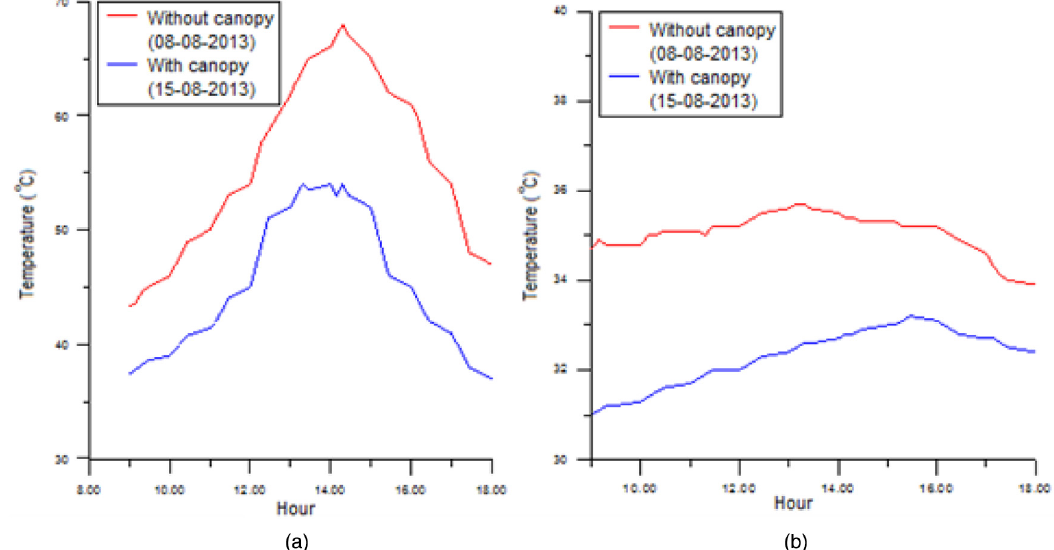
Fig. 6. Surface temperatures of the roof in the ef fi cient model. (a) external surface temperature; (b) internal surface temperature.